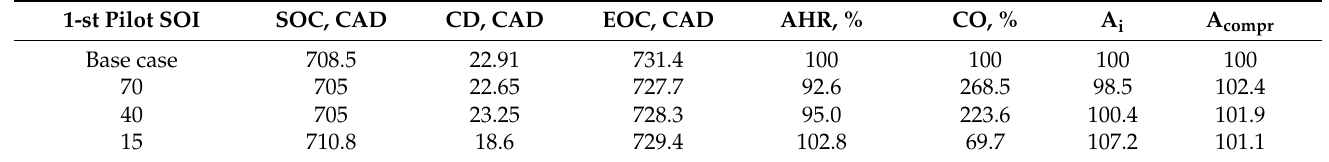
Table 3. Combustion parameters for the 2nd pilot SOI 10 CAD before